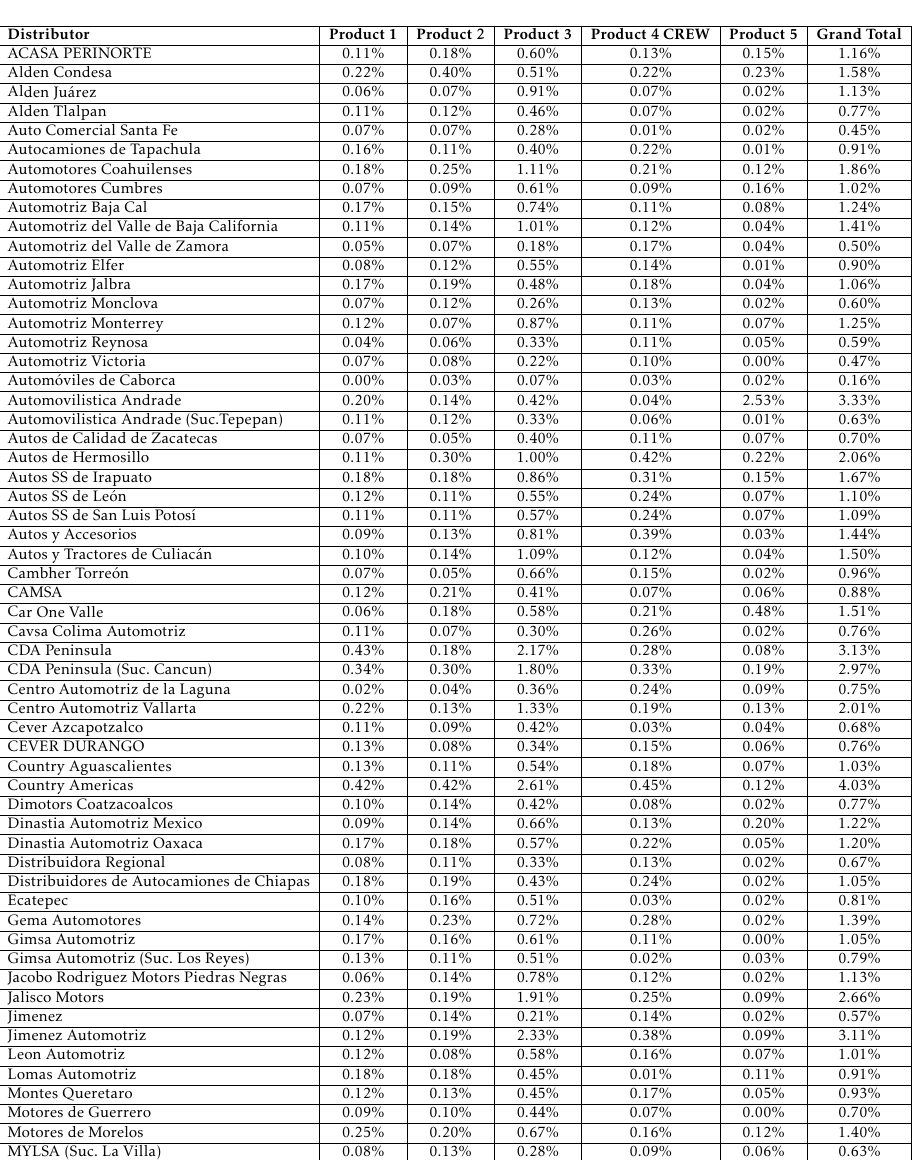
Table 7. Percentage of allocation per vehicle line by